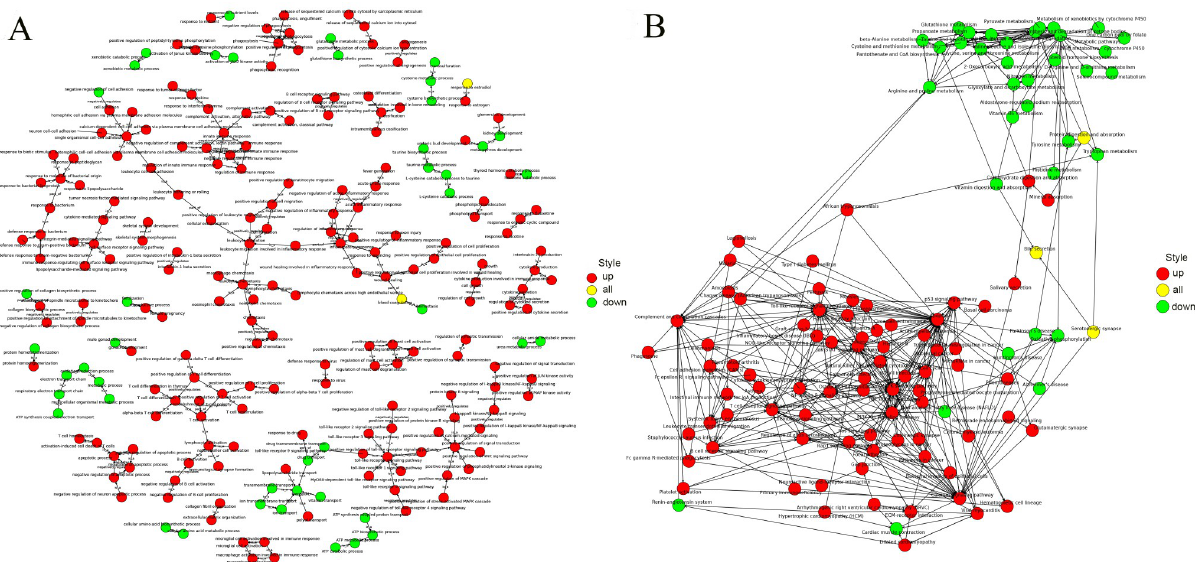
Fig 5. The GO-Trees and the Pathway-Act-Network. (A) Hierarchical tree diagram among salient functions and GO trees of significant GO terms (P < 0.01). Green indicates significant GO terms in which downregulated genes are involved, red indicates significant GO terms in which upregulated genes are involved, and yellow indicates significant GO terms in which both upregulated and downregulated genes are involved. (B) Signalling pathway regulatory network. The upregulated and downregulated pathway terms (P < 0.05). Green indicates the significant pathway term involved in downregulated genes, red indicates the significant pathway term involved in upregulated genes, and yellow indicates the significant pathway term involved in both upregulated and downregulated genes.